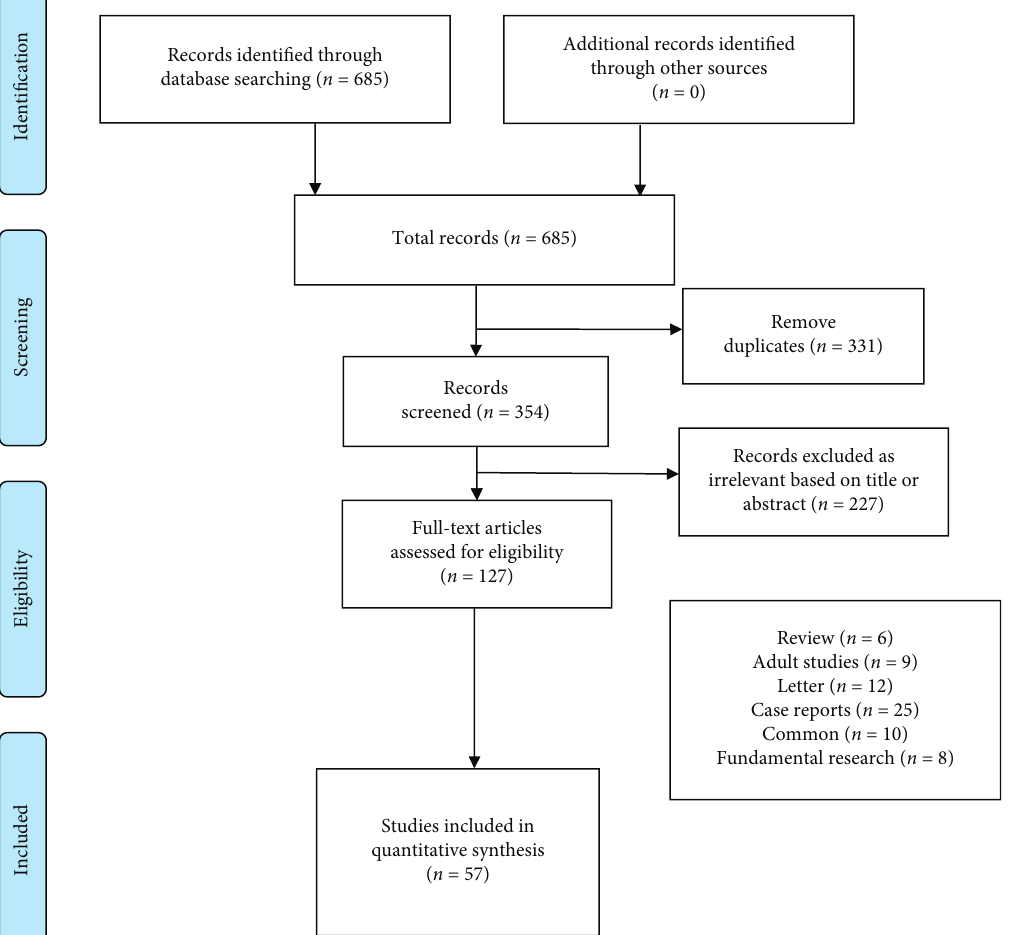
Figure 1: Flow diagram for identification of selected studies in the